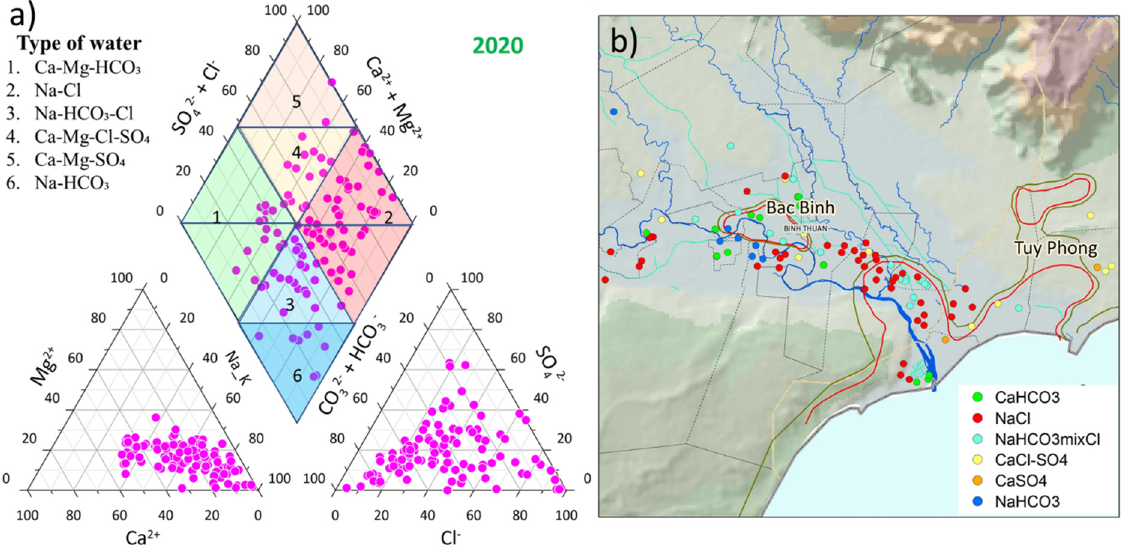
Figure 6. ( a ) Piper diagrams of groundwater samples in the Luy river catchment (the purple balls) and ( b ) water type from the Piper diagram distribution.